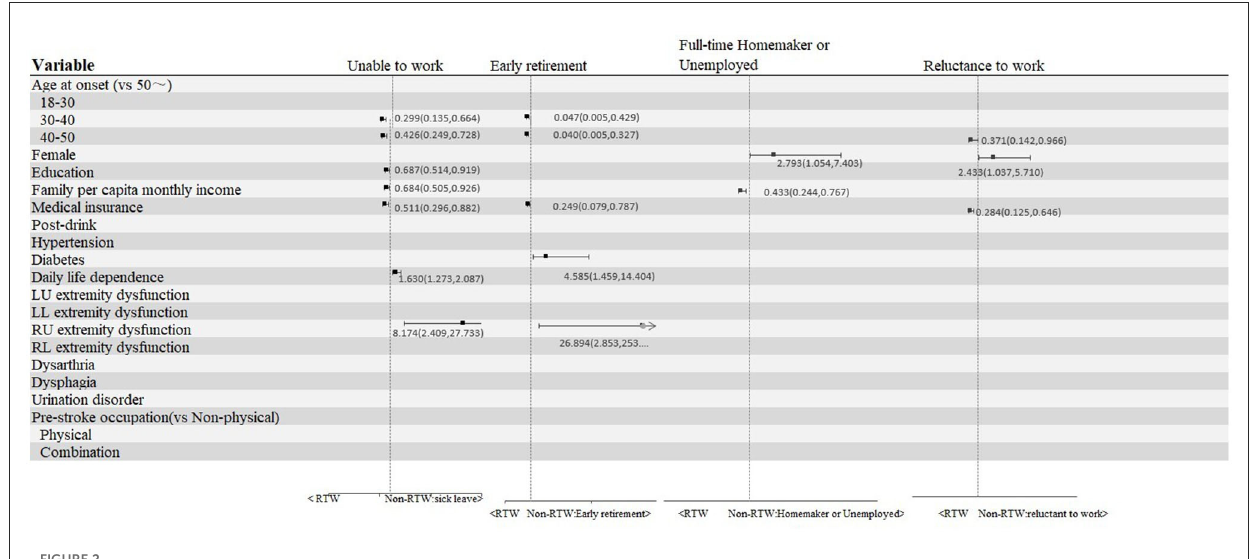
FIGURE2 Variables statistically significantly associated with at least one of the four non-RTW